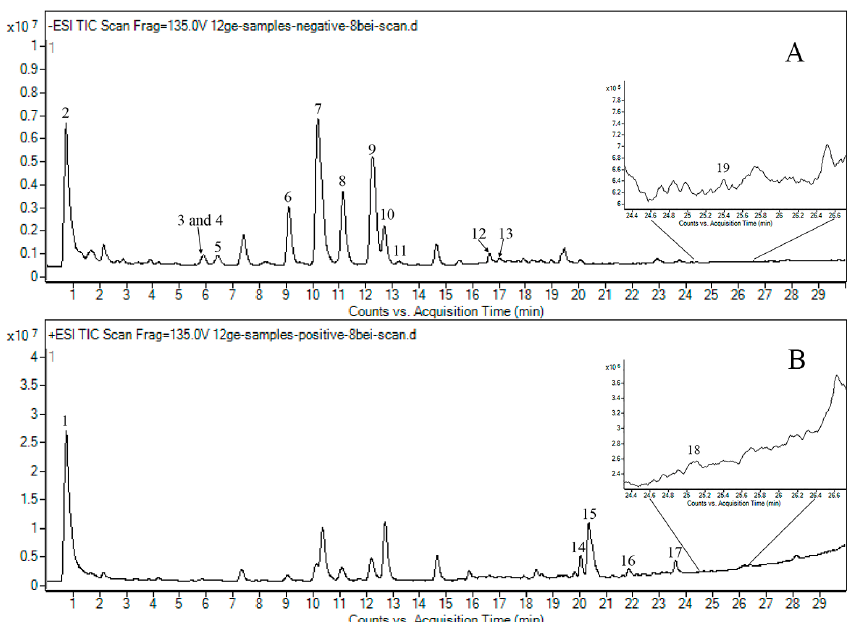
Figure 2. Total ion current scan chromatogram of negative ion ( A ) and total ion current scan chromatogram